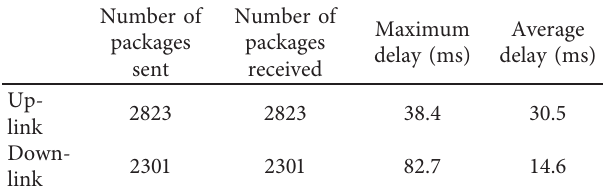
Table 3: Performance statistics of LTE-M one-way transmission under clock synchronous condition.